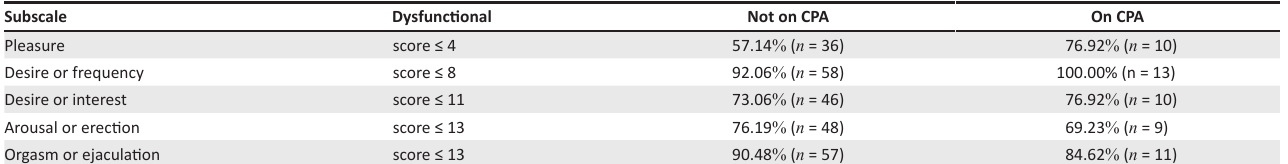
TABLE 4: Numbers and percentages of participants on and not on CPA that have CSFQ-M-C subscale scores which are indicative of the presence of sexual dysfunction in a particular area of sexual functioning. Subscale